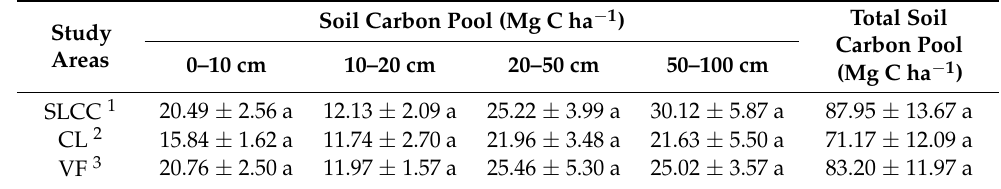
Table 4. The total mean of soil carbon pool (Mg C ha − 1 ) at four different depths (0–100 cm) in supervised logging with climber cutting areas (SLCC), conventional logging areas (CL), and virgin forest areas